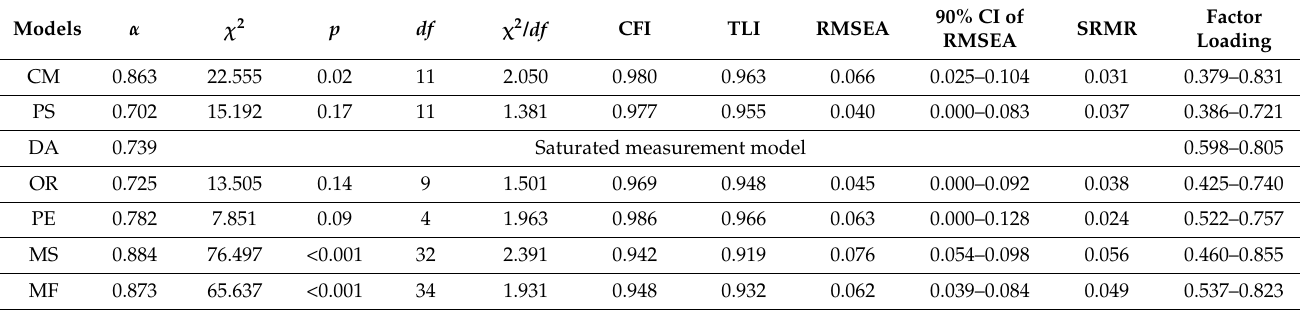
Table 1. Model fit of the measurement model ( n =